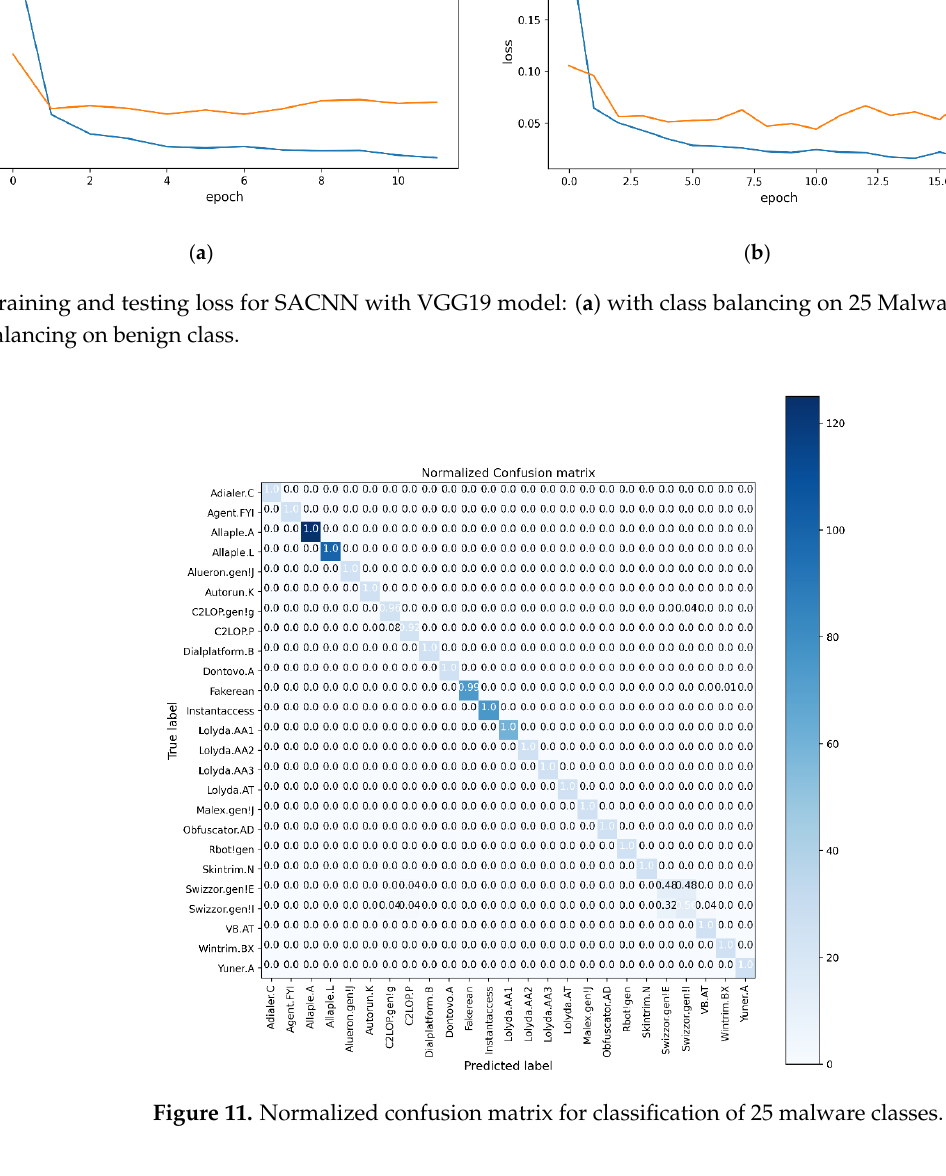
Figure 12. Normalized confusion matrix for classification with class balancing and benign class.